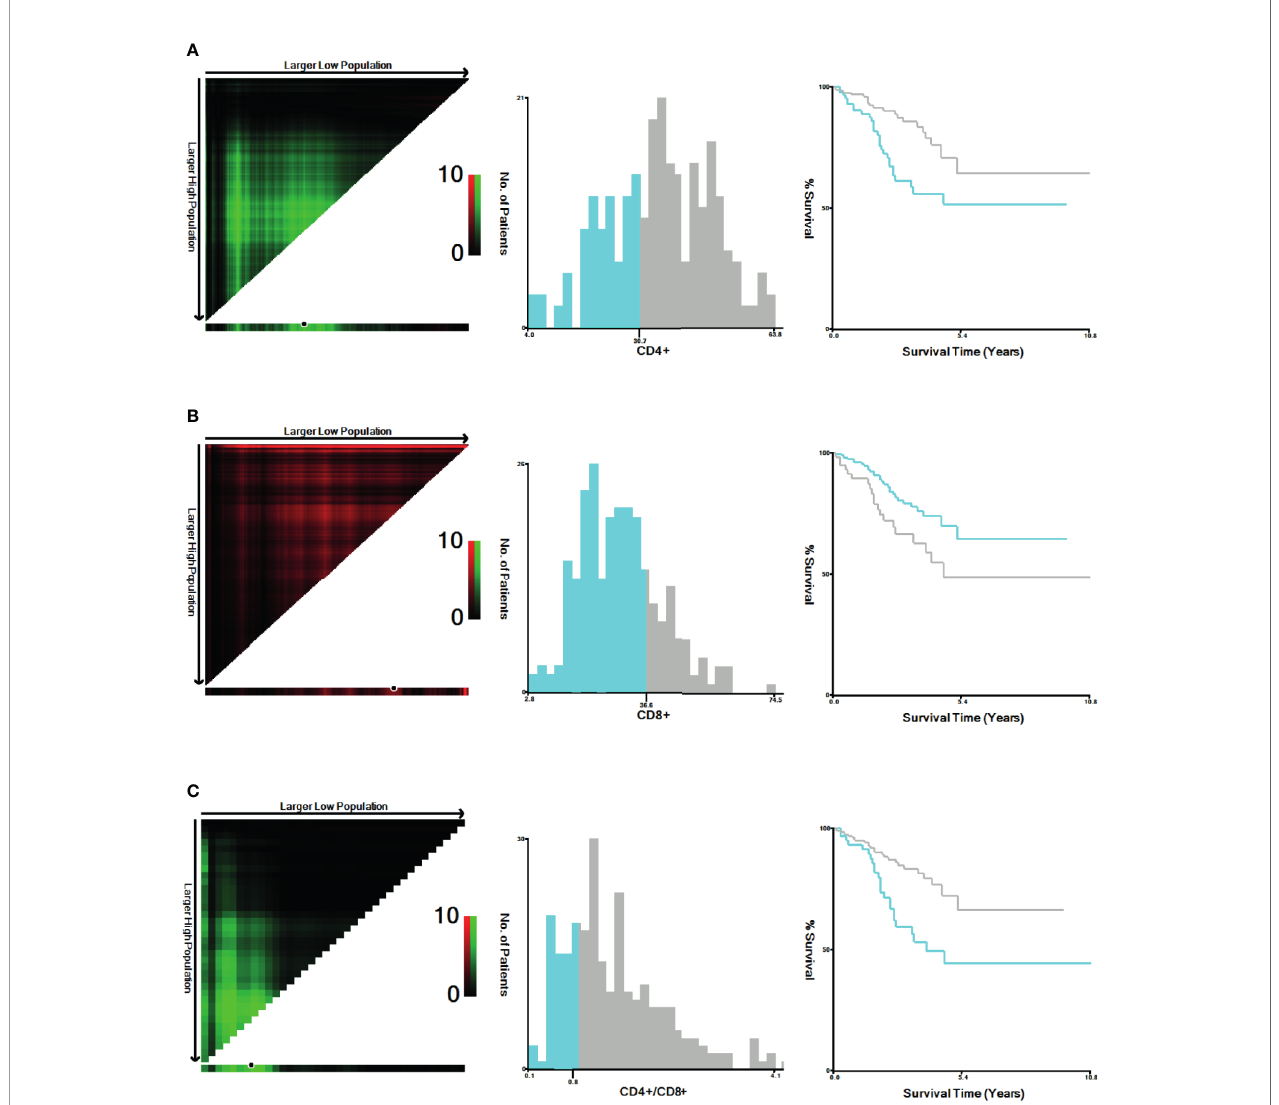
FIGURE 1 | Cut-off values determination for CD4+, CD8+ and CD4+/CD8+ and survival analyses. The optimal cut-off values, denoted by black circles in the left panels, are displayed in histograms of the entire cohort (middle panels), and Kaplan-Meier plots are displayed in the right panels. (A) The optimal cut-off values for CD4+ was 30.7% ( c 2 = 10.036, P=0.005). (B) for CD8+ was 36.6% ( c 2 = 5.238, P =0.023). (C) for CD4+/CD8+ was 0.8 ( c 2 = 10.637,